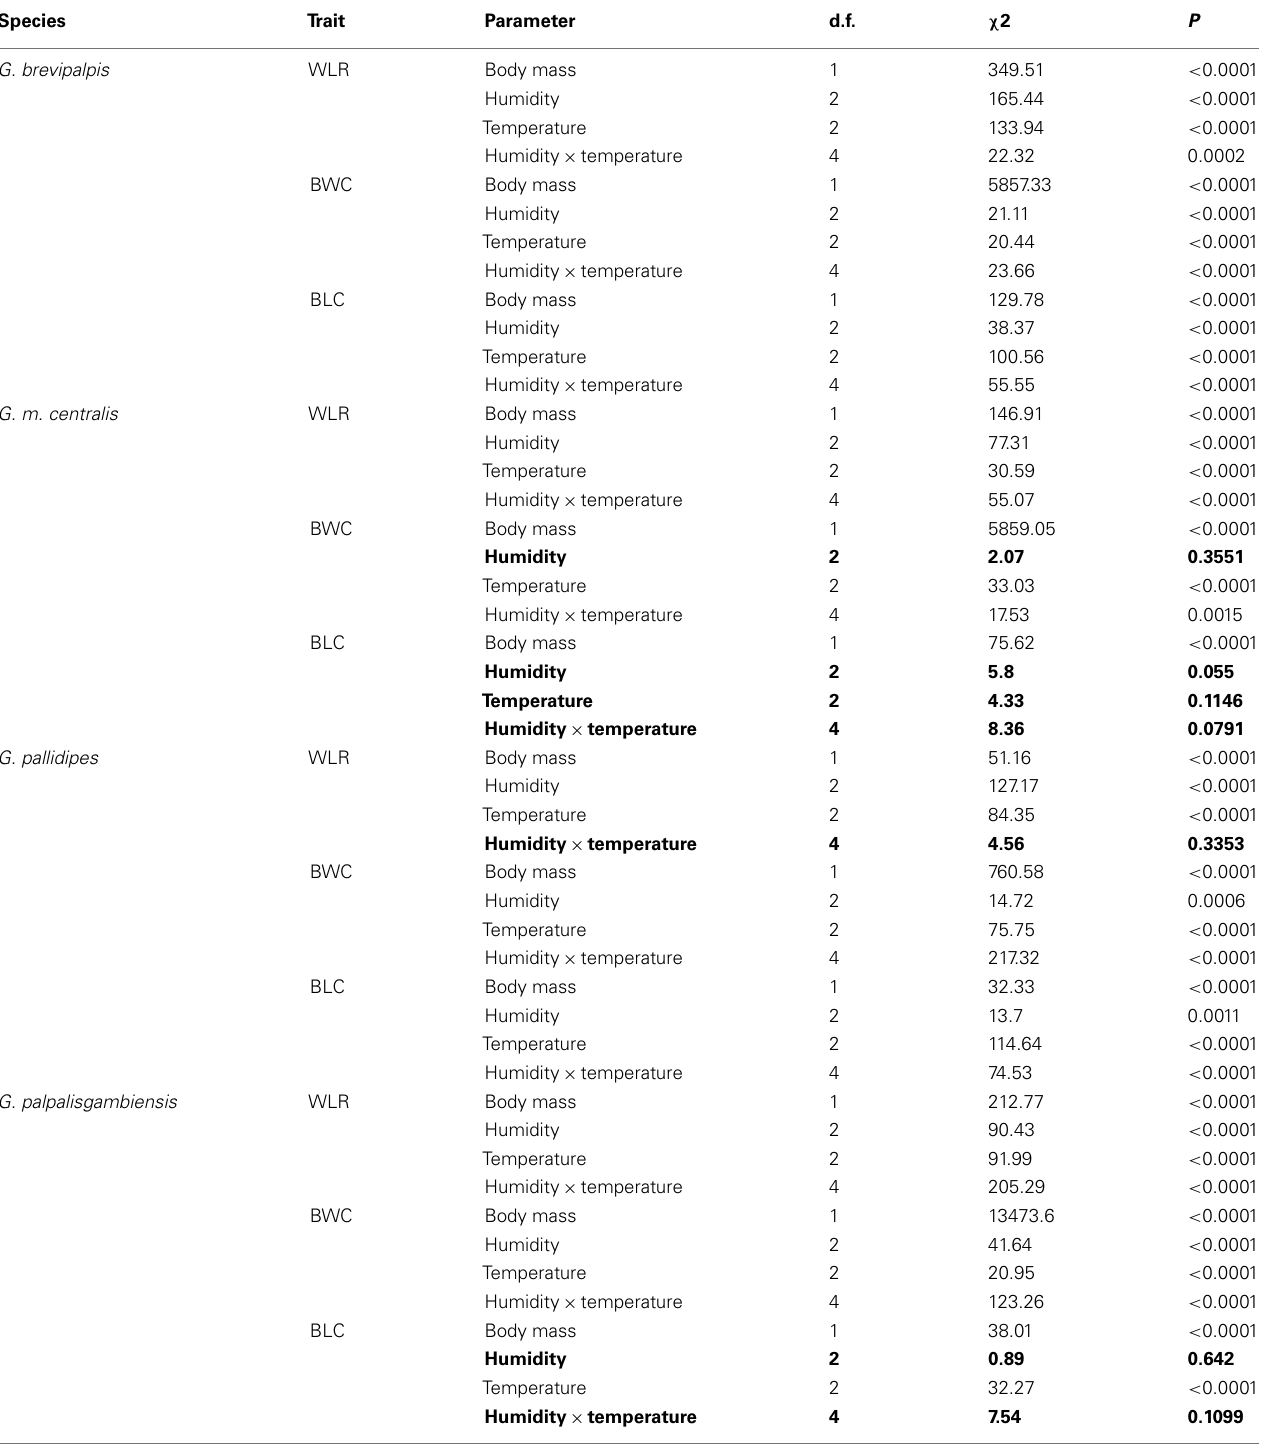
Table 1 | Summary of generalized linear model results [degrees of freedom (d.f.), chi-square ( χ 2 ) statistic, and corresponding P -value ( P )] for water loss rate (WLR in mg/h), body water content (BWC in mg), and body lipid content (BLC in mg) as dependent variables, initial body mass as a continuous predictor and relative humidity, temperature, or temperature and relative humidity interaction effect (indicated with × ) as independent